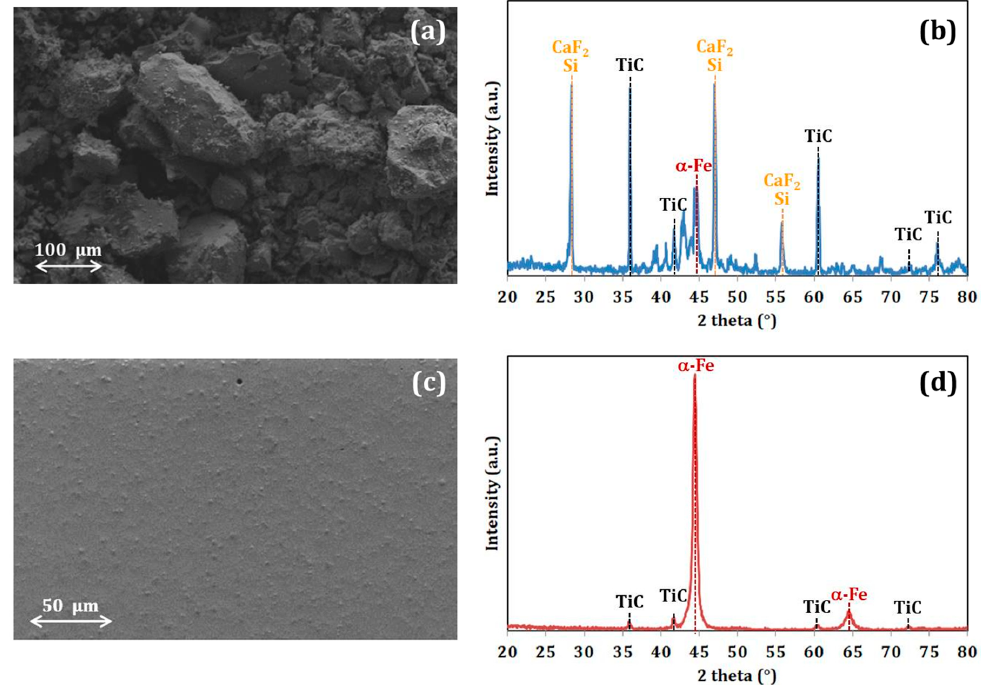
Figure 12. ( a ) SEM micrograph and ( b ) X-ray diffraction (XRD) spectrum, respectively, of the core powder of the wire used for flux core arc welding (FCAW) deposits. ( c ) SEM micrograph and ( d ) XRD spectrum, respectively, of the obtained hardfacing layers.